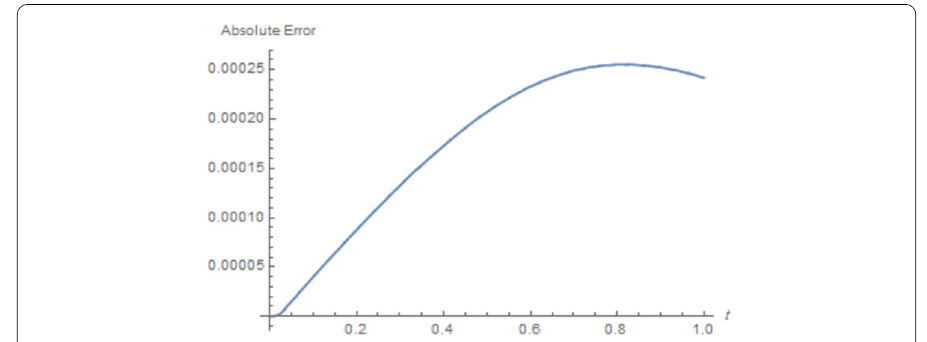
Figure 3 Absolute error of Example 5.3 when α = 1 and n = 30